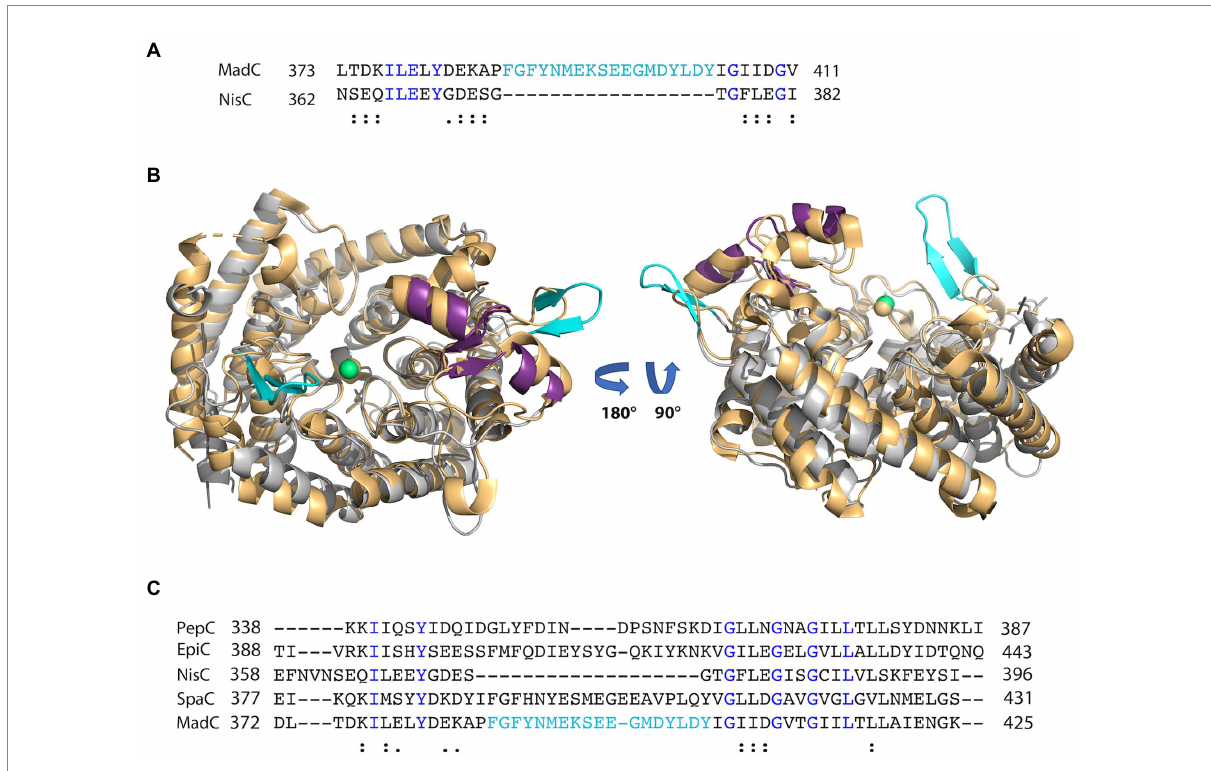
FIGURE 3 Alignment of class I LanC’s and structural comparison. (A) Sequence alignment of MadC and NisC via Clustal Omega. Blue colored amino acids indicate identical amino acids for this 2 sequence alignment, “:” indicates very similar amino acids; “.” indicates similar amino acids. Cyan colored amino acids display the β -sheet element near the catalytical zinc ion in MadC. (B) Structural superimposition of NisC (golden; PDB: 2G02) and MadC. MadC is colored in light grey except of the SH2-like domain (magenta) and the extended β -sheets in cyan. The alignment of the structures was performed in PyMOL. (C) Sequence alignment of selected class I LanC’s via Clustal Omega. Blue colored amino acids indicate identical amino acids for this specific alignment, “:” indicates very similar amino acids; “.” indicates similar amino acids. Cyan-colored amino acids display the β -sheet element near the catalytical zinc ion in MadC.